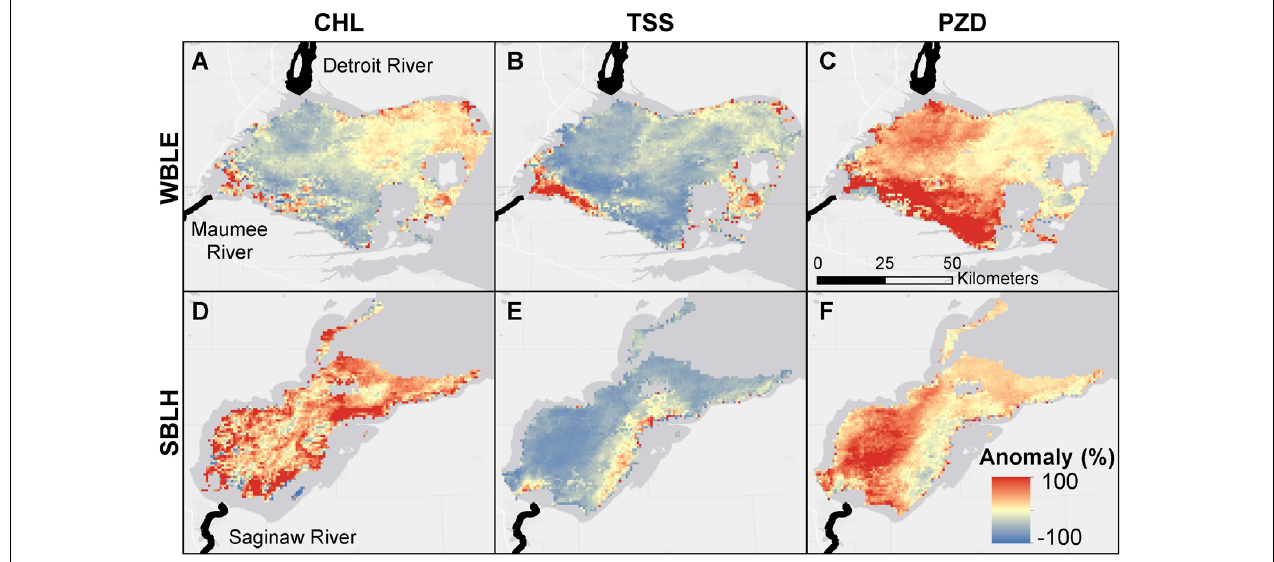
FIGURE 4 | April anomaly maps for CHL, total suspended solids (TSS), and PZD in the two study basins. All maps are scaled from blue (large negative anomaly) to red (large positive anomaly). The locations of each basin’s major rivers (Maumee and Detroit Rivers in WBLE; Saginaw River in SBLH) and where they enter the basins are displayed in black. (A–C) The WBLE April anomaly maps for CHL, TSS, and PZD, respectively. (D–F) The SBLH April anomaly maps for CHL, TSS, and PZD, respectively.